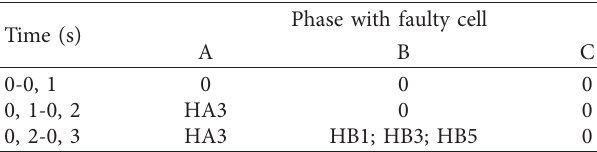
Table 6: Simulation